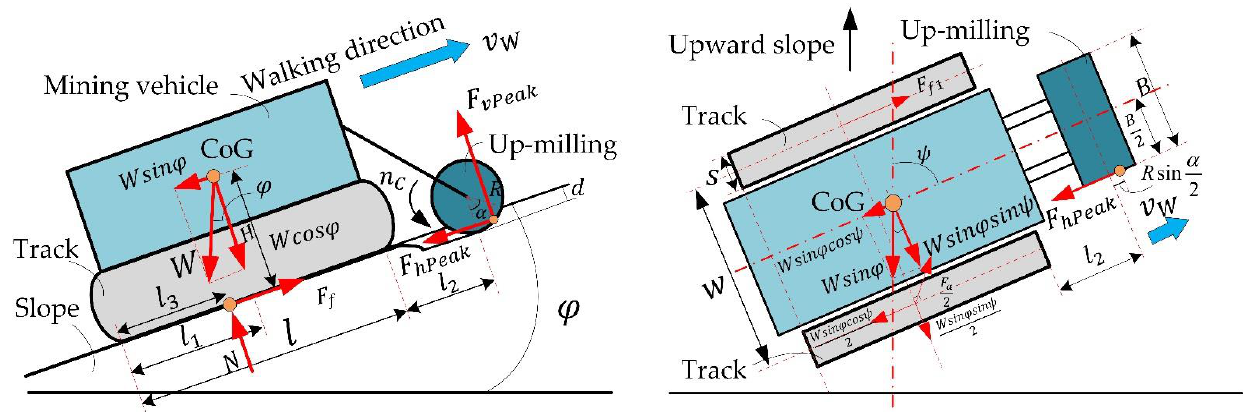
Figure 6. Anti-slip stability diagram of mining vehicle with up-milling cutting head.